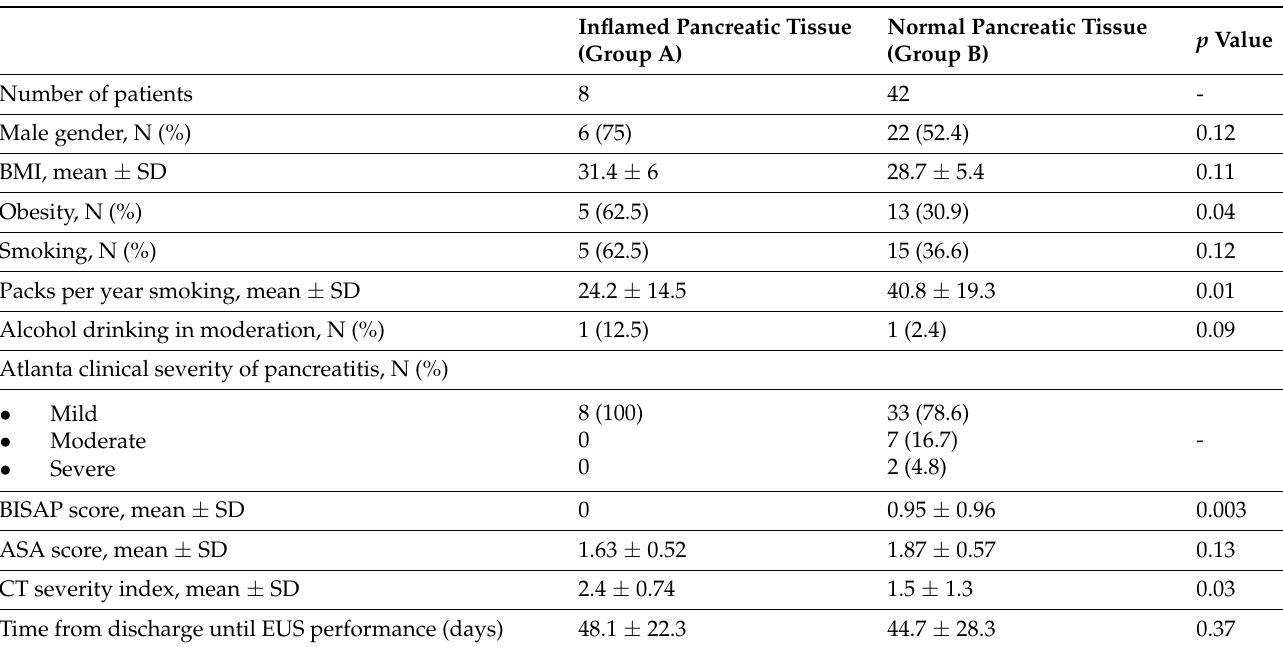
Table 2. Characteristics of patients with inflamed and normal pancreatic tissue on